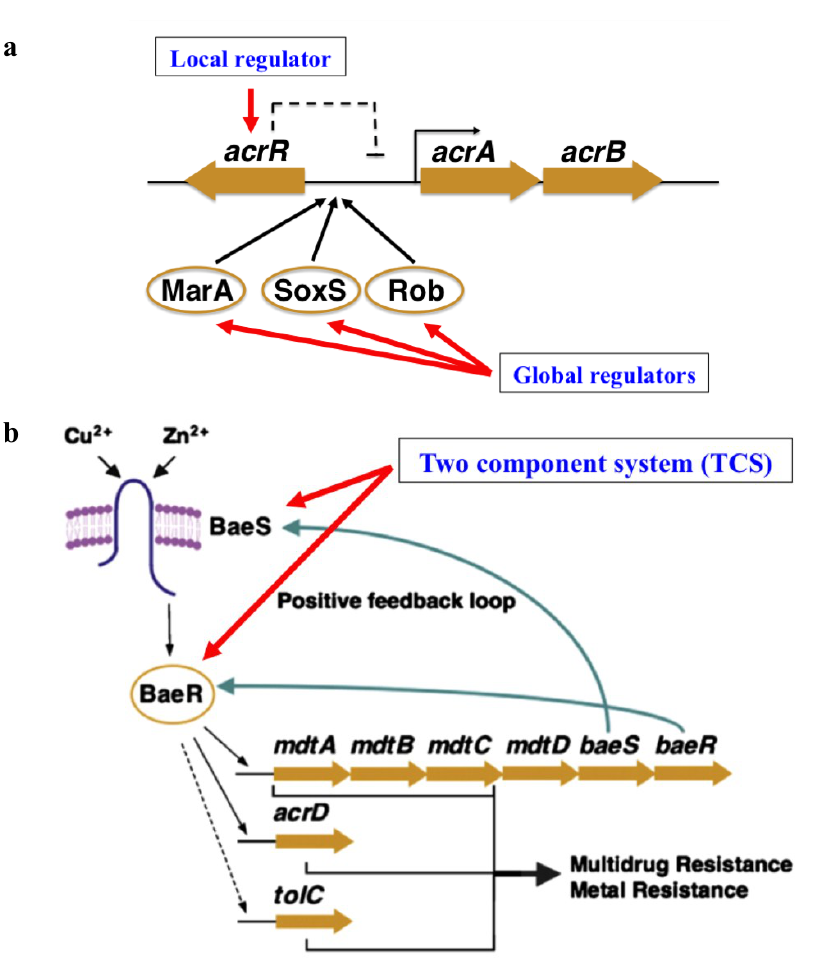
Figure 1. Regulatory patterns of multidrug efflux pumps (using those in Salmonella typhimurium as an example). ( a ) Local repressor and global regulators: local regulator AcrR inhibits the expression of acrAB operon and global regulators MarA, SoxS, and Rob act as inducers of acrAB in response to different signals; ( b ) Two component system (TCS): BaeRS activates expression of the mdt operon, acrD , and tolC . Figures are adopted and modified based on those by Nishino et al. and Blair et al.